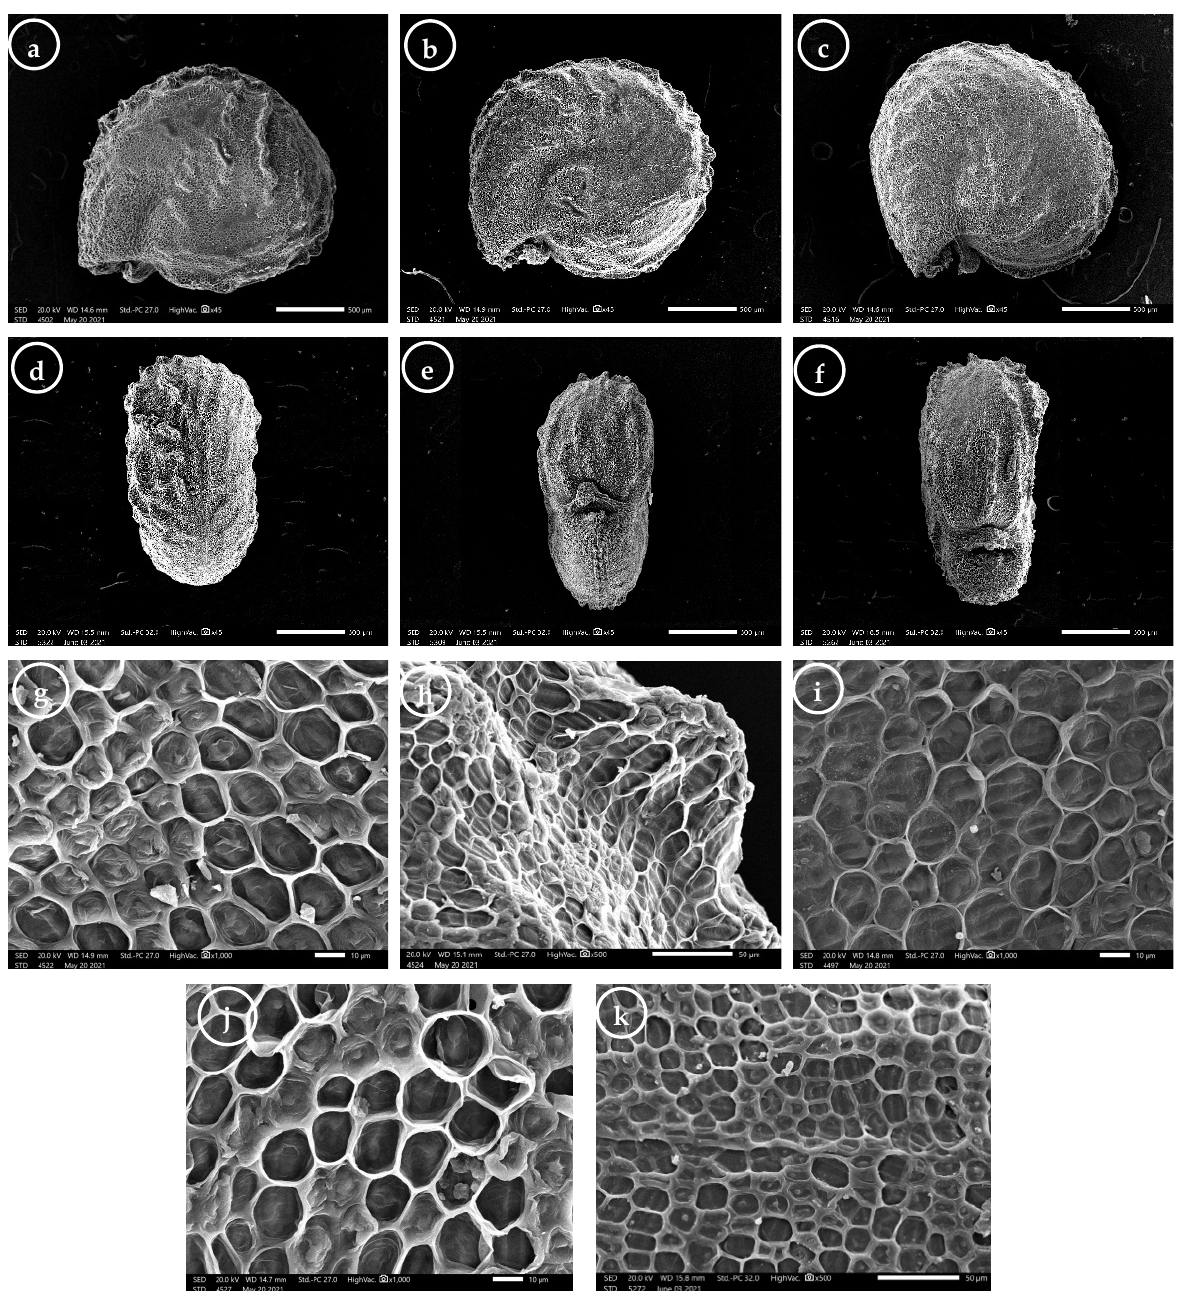
Figure 5. Scanning electron microscope (SEM) photomicrographs of Trianthema portulacastrum seeds: ( a – c ) general view of the lateral side of the seed, showing shape, apex, margin, and rib prominence; ( d ) general view of the dorsal side of the seed, showing number of ribs; ( e , f ) general view of the ventral side of the seed, showing the different hilum positions; ( g – k ) seed surface, showing the epidermal cell outline, anticlinal wall, relief of the cell boundary, curvature of the outer periclinal cell walls, shape of the periclinal walls’ protrusions, and fine relief of the cell wall. ( g , i , j ) Lateral side at the seed center; ( h ) lateral side at the seed edge; ( k ) dorsal side at the seed center. Scale bar = 500 µ m ( a – f ); 50 µ m ( h , k ); 10 µ m ( g,i,j